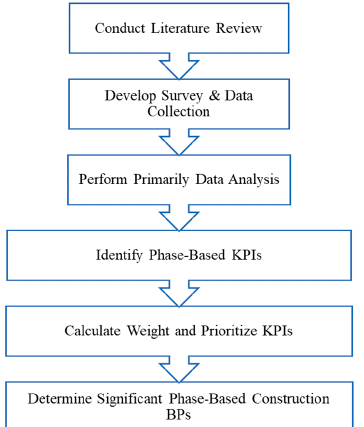
Figure 1. Research Methodology Process.